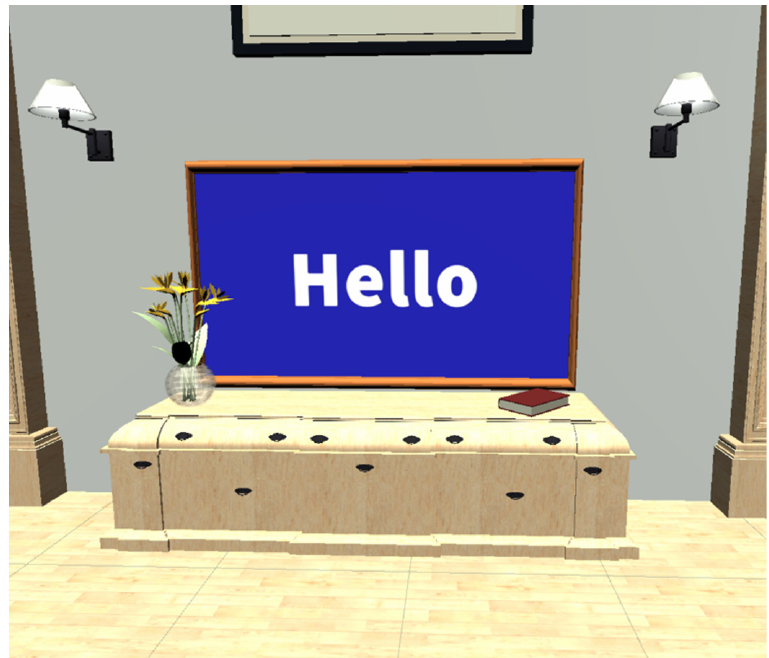
Figure 2. Image of television to demonstrate video and sound in VR.